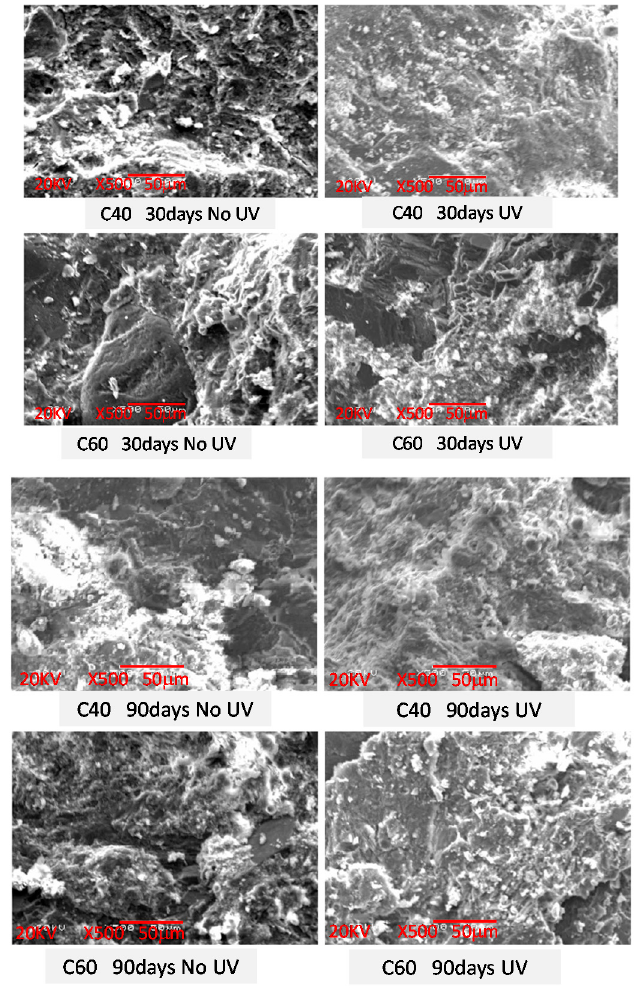
Figure 15. SEM comparison of concrete before and after UV exposure.